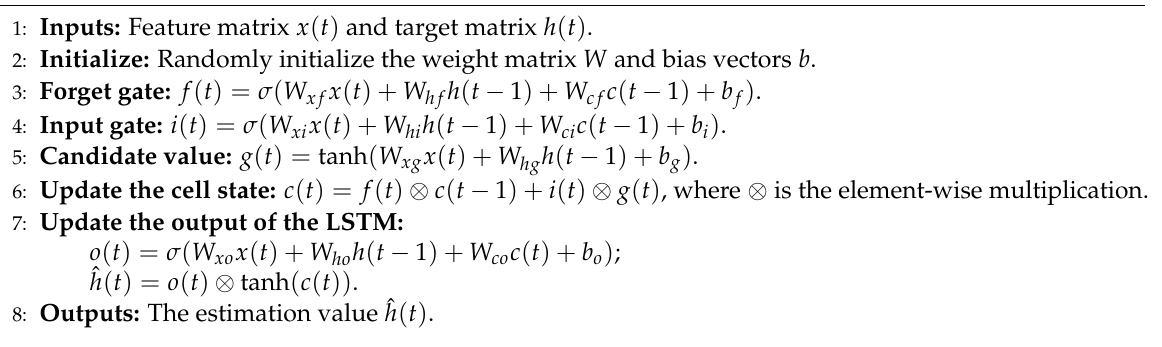
Algorithm 1 LSTM forward propagation